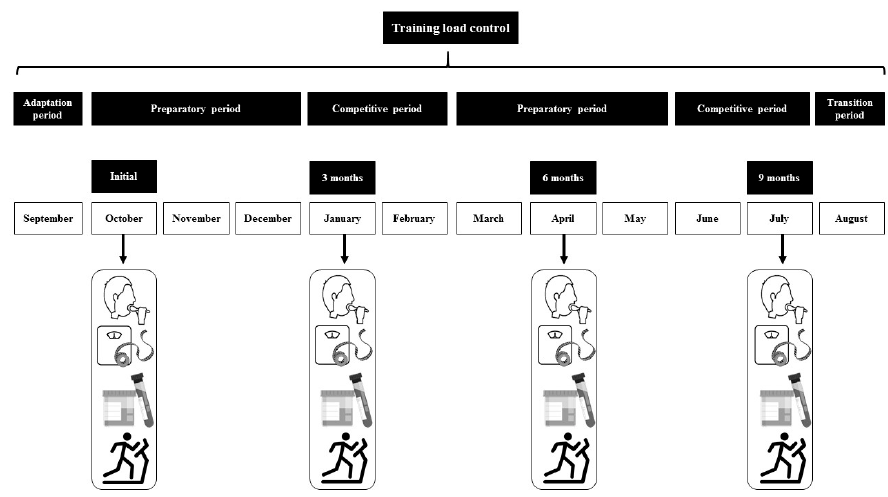
Figure 1. Periodization and testing during the season.